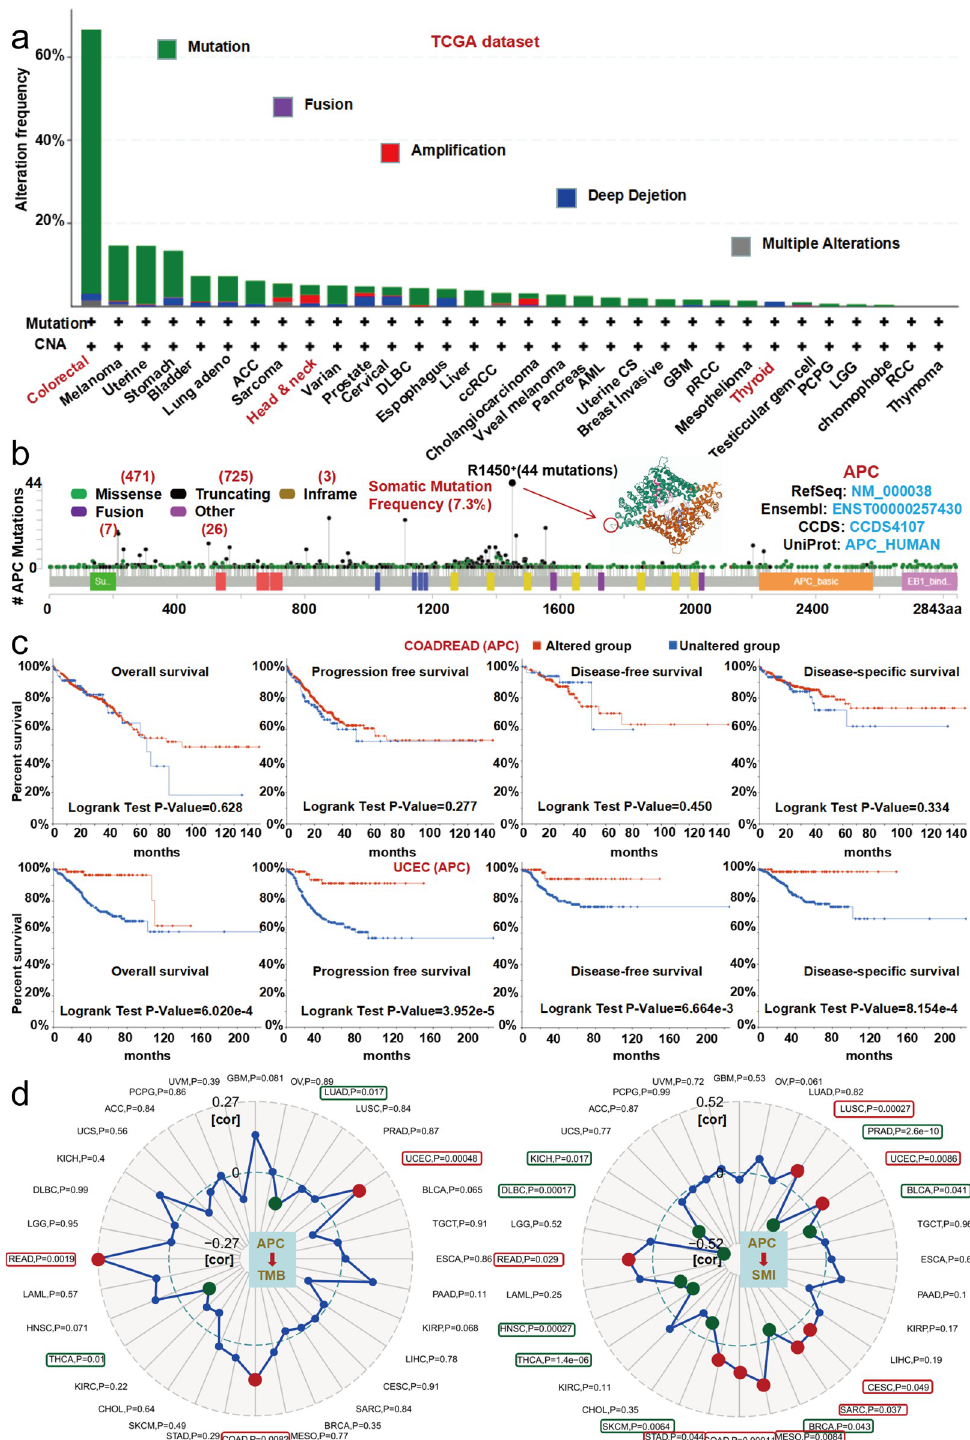
Fig 6. Genetic alteration analysis of APC revealed by use of the cBioPortal tool. (a) The alteration frequency with mutation type. (b) The alteration frequency of mutation site. (c) The latent correlation between mutation status and survival status. (d) The latent correlation between APC expression and tumor mutational burden) (TMB (cor: +0.27 and -0.27) as well as microsatellite instability (MSI) (cor: +0.52 and -0.52).